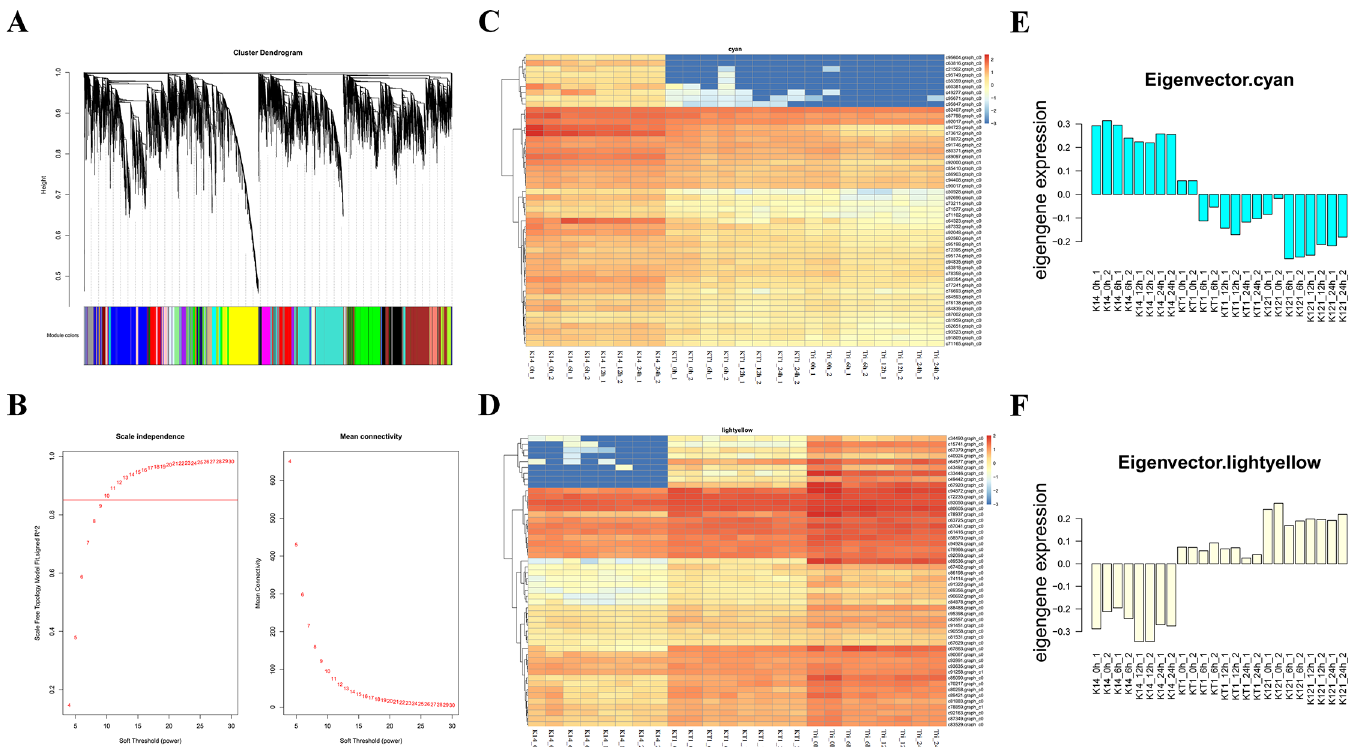
Fig 2. WGCNA module building, Hubgenes cluster analysis, and EigenGene expression statistics. (A, B) Hierarchical clustering of co-expression data. (C) Heatmap cluster of Hubgenes from cyan module. (D) Heatmap cluster of Hubgenes from light yellow module. (E) Eigengenes expression pattern in cyan module. (F) Eigengenes expression pattern in light yellow